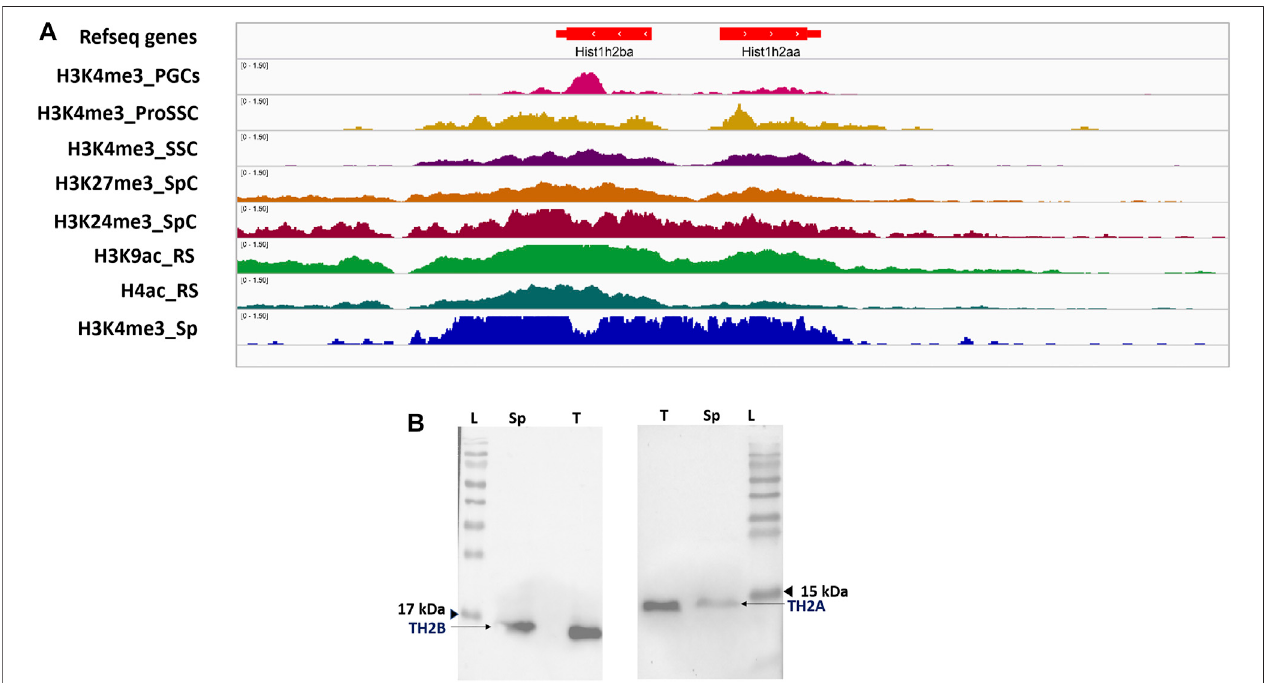
FIGURE2| TH2AandTH2Bareretainedinsperm. (A) IGVgenomebrowserviewforalignmentofChIP-AtlasbigWigtrackforpost-translationallymodi fi edhistones atthemurine hist1h2aa and hist1h2ba locusacrossPrimordialgermcellsandsubsequentmalegermcellstages. (B) WesternblotshowingpresenceofTH2AandTH2B in the mature caudal sperm (Sp) and whole testicular cell lysate (T); protein molecular weight marker (L).